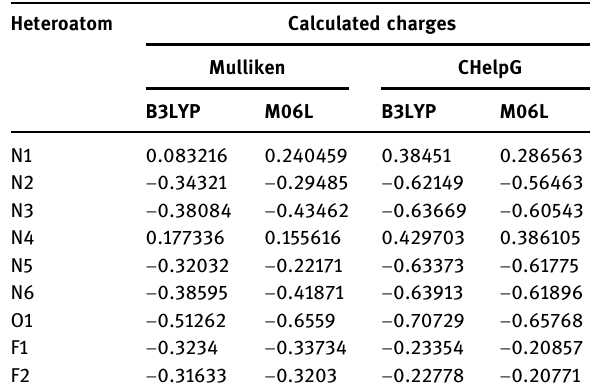
Table 2: Atomic charges [ e ] for nitrogen and oxygen atoms within the structure of fl uconazole ( geometry optimized at the B3LYP/6 - 311 + G ( d,p ) or M06L/6 - 31G ( d,p ) levels of theory in gaseous phase,